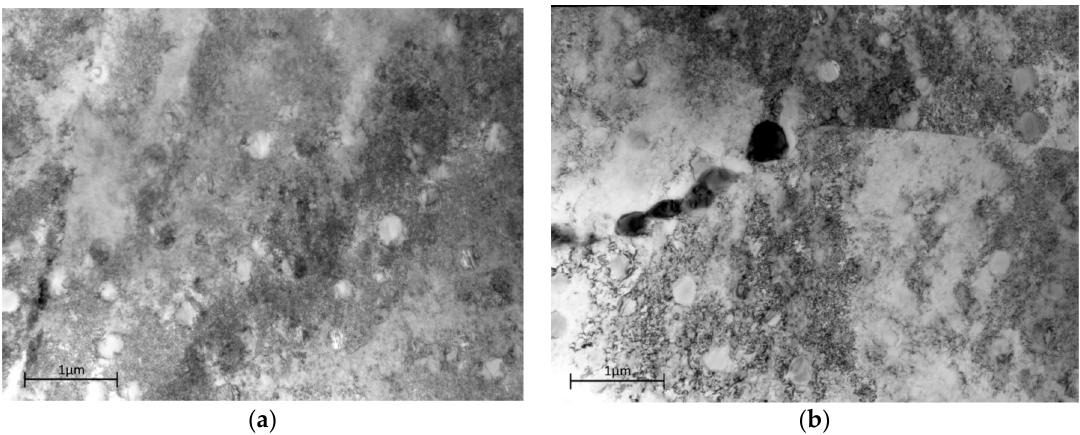
Figure 13. Dislocation structure in Waspaloy subjected to creep loading at 800 MPa (above the yield stress) in the ( a ) grains ( b ) grain boundary zones.